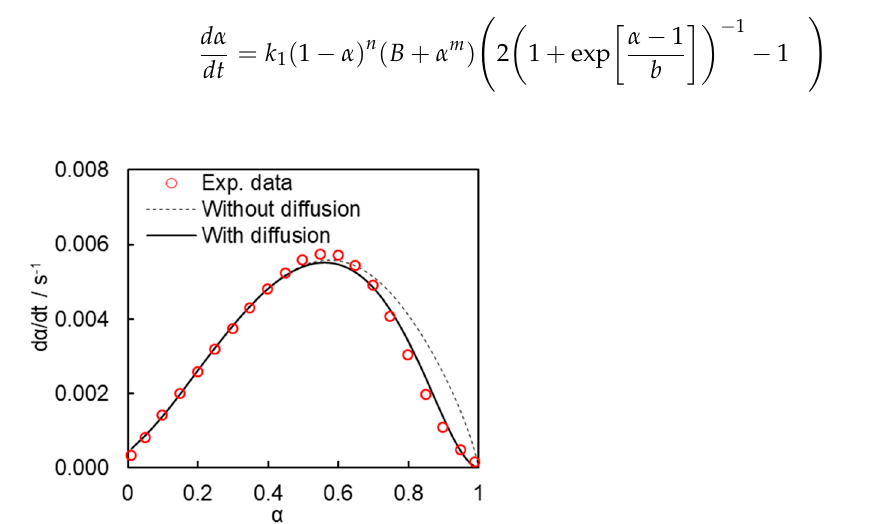
Figure 9. The diffusion factor f d ( α ) values averaged over all heating rates calculated with kinetic parameters from Table 1 (diamonds) and the best fit by Equation (12) (dashed line).